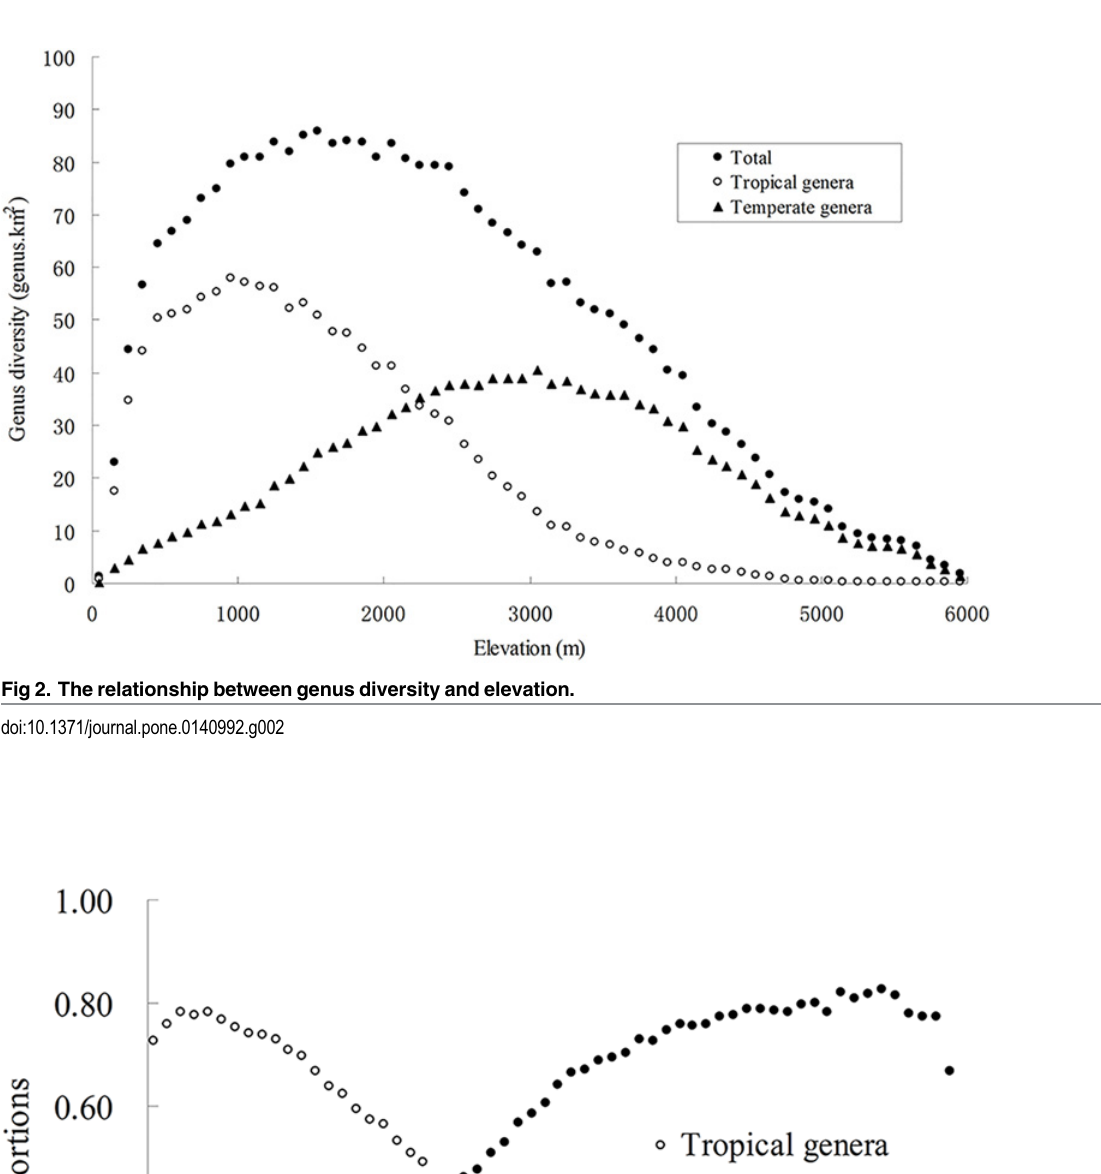
PLOS ONE | DOI:10.1371/journal.pone.0140992 October 21,